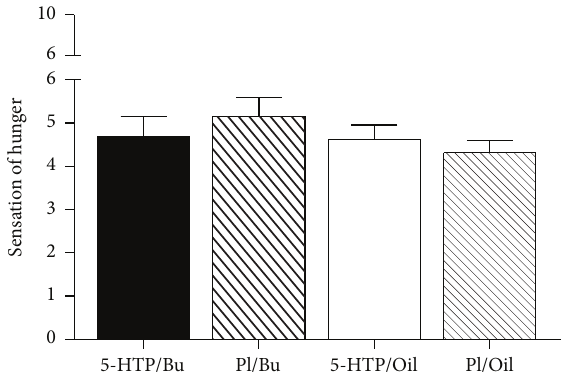
Figure 4: Cortisol. The influence of 5-hydroxytryptophan (5-HTP) and fatty acid ingestion on the circadian profile of saliva cortisol concentrations. Participants received a capsule with either 5-HTP or placebo (Pl). They also ingested a standard breakfast supplemented with100 𝜇 L 13 Coctanoidacidandeitherbutter(Bu)oroliveoil(Oil). Saliva samples were taken during fasting (t1 at 8:00) and after 5- HTP or placebo intake after 1:45 hrs (t2), 2:45 hrs (t3), 3:45 hrs (t4), and 4:45 hrs (t5). The actual saliva concentrations of cortisol protein are presented as means ± SE. Statistics: cortisol; time: ( F = 53.814; 𝑃 < 0.001 ).